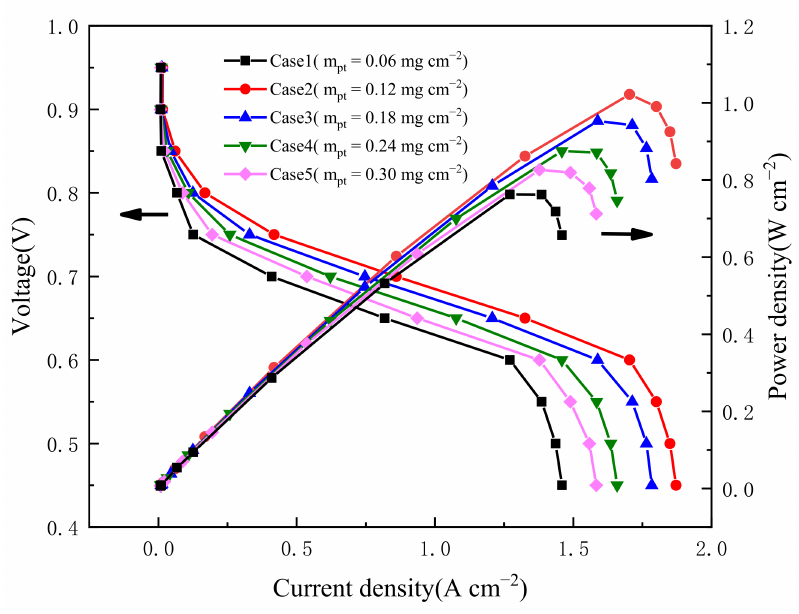
Figure 9. Effect of Pt loading on cell performance.